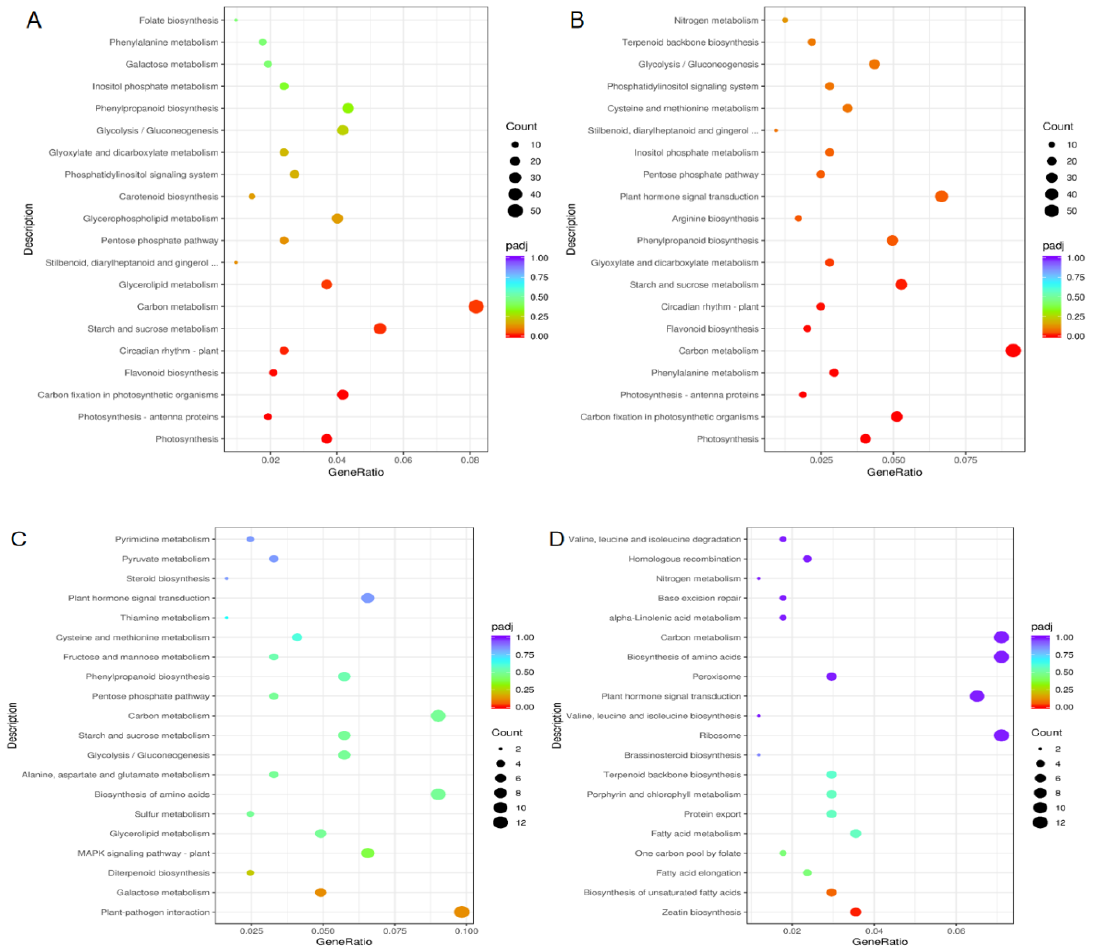
Figure 10. KEGG enrichment analysis of differentially expressed genes (DEGs) in rust-resistant (RR) and rust-susceptible (RS) Z. japonica lines. RR1, RR without inoculation; RS1, RS without inoculation; RR2, RR inoculated for 5 days; RS2, RS inoculated for 5 days. ( A ) Up-regulated gene RR2 relative to RR1; ( B ) Up-regulated gene RS2 relative to RS1; ( C ) Up-regulated genes of RR2 relative to RS2; ( D ) Down-regulated genes of RR2 relative to RS2.